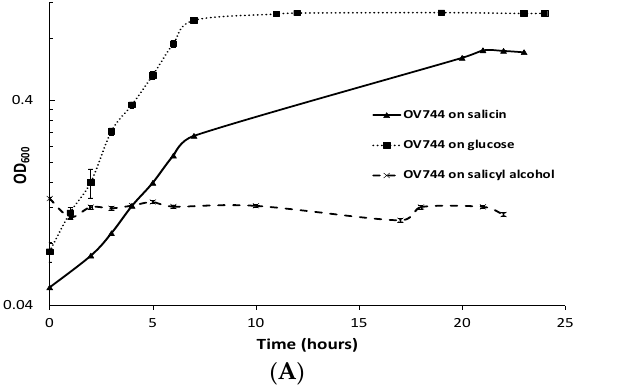
Table 2. Probable proteins involved in salicin degradation for R. aquatilis OV744 were detected in proteome of salicin cultures, but not in glucose cultures.